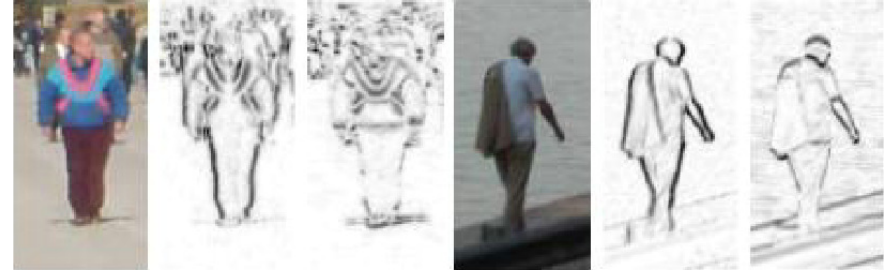
Figure 8. Shapelet Features from Two Sample Images. Each computed in one direction